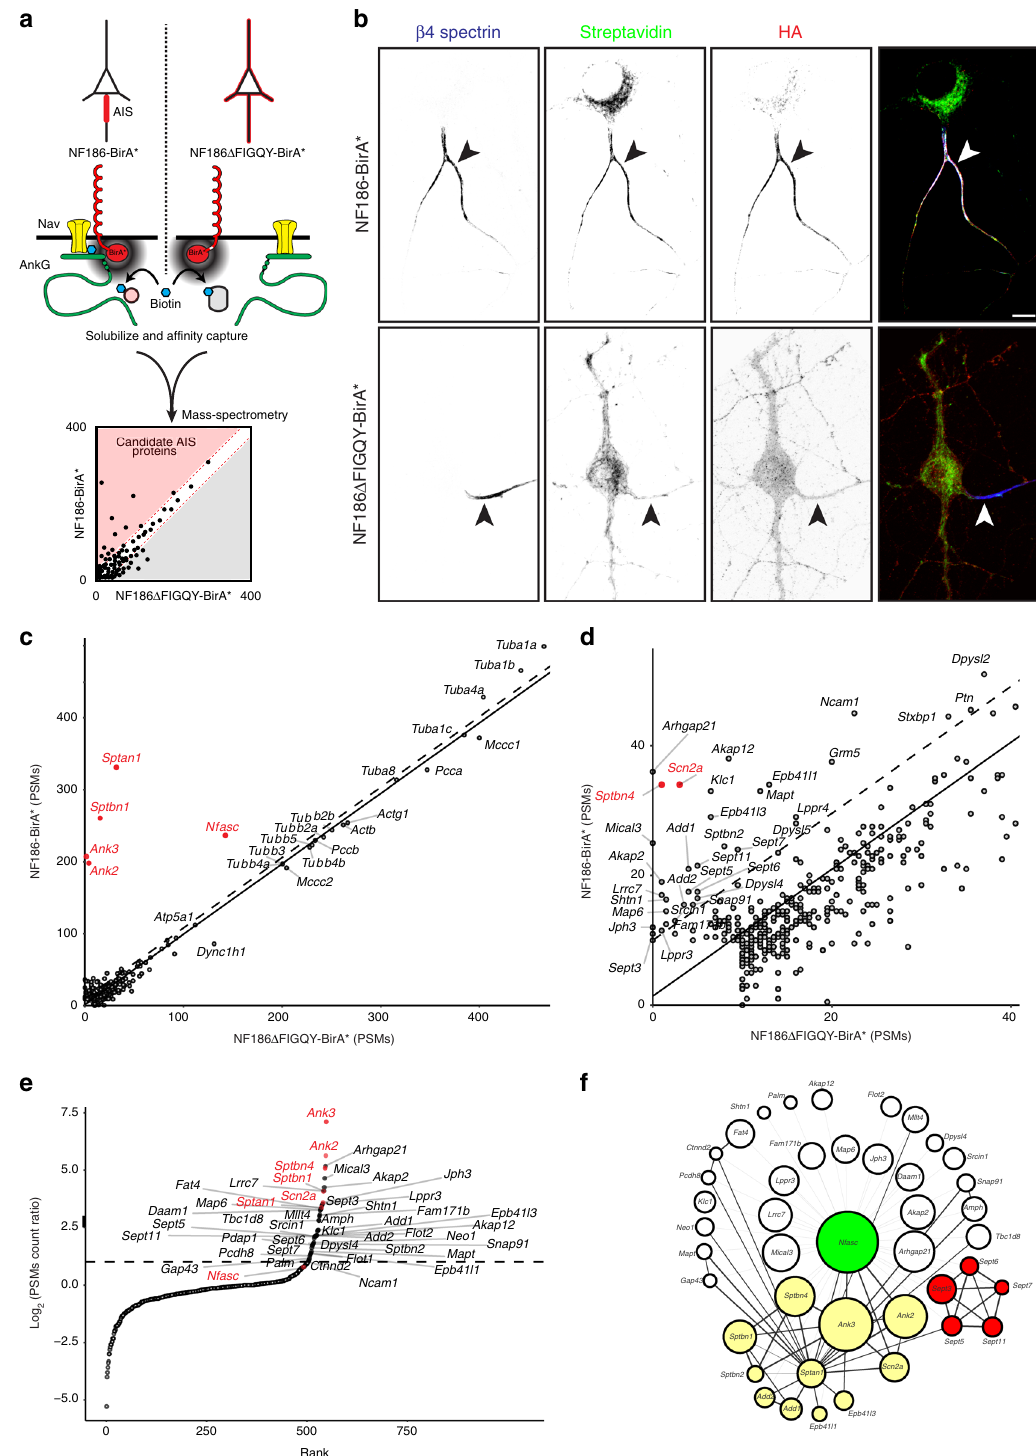
NF186 Δ FIGQY-BirA* expressing neurons (Fig. 1e). The greatest enrichment for proteins in proximity to NF186 are AnkG ( Ank3 ) and AnkB ( Ank2 ); this is consistent with our strategy to use the non-ankyrin binding NF186 Δ FIGQY-BirA* chimera as a control. Altogether, these observations demonstrate the robustness of our approach using proximity biotinylation to capture AIS proteins. Using the proteins enriched in the NF186-BirA* sample (Fig. 1e), we generated a protein interaction network using Cytoscape and the STRING database of protein – protein association networks 29,30 .